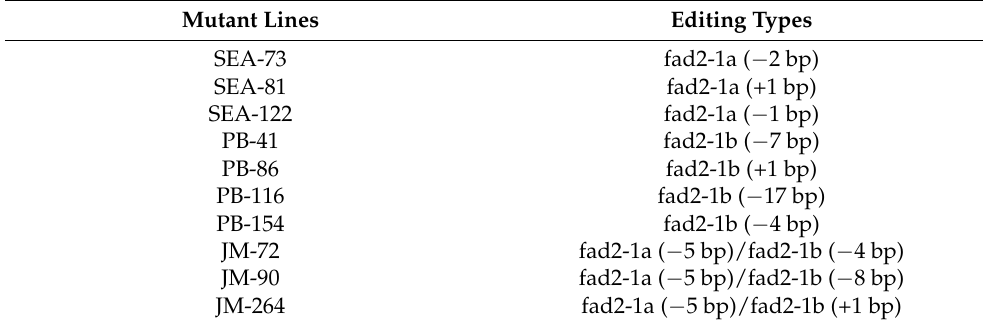
Table 1. The wild-type soybean Jack was included as a control. Table 1. Mutants types used for determination.